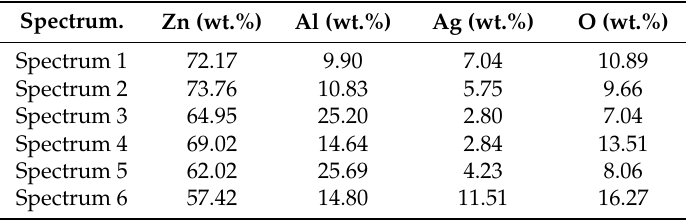
Table 6. The phase composition of Al 2 O 3 /Zn6Al6Ag joint boundary.